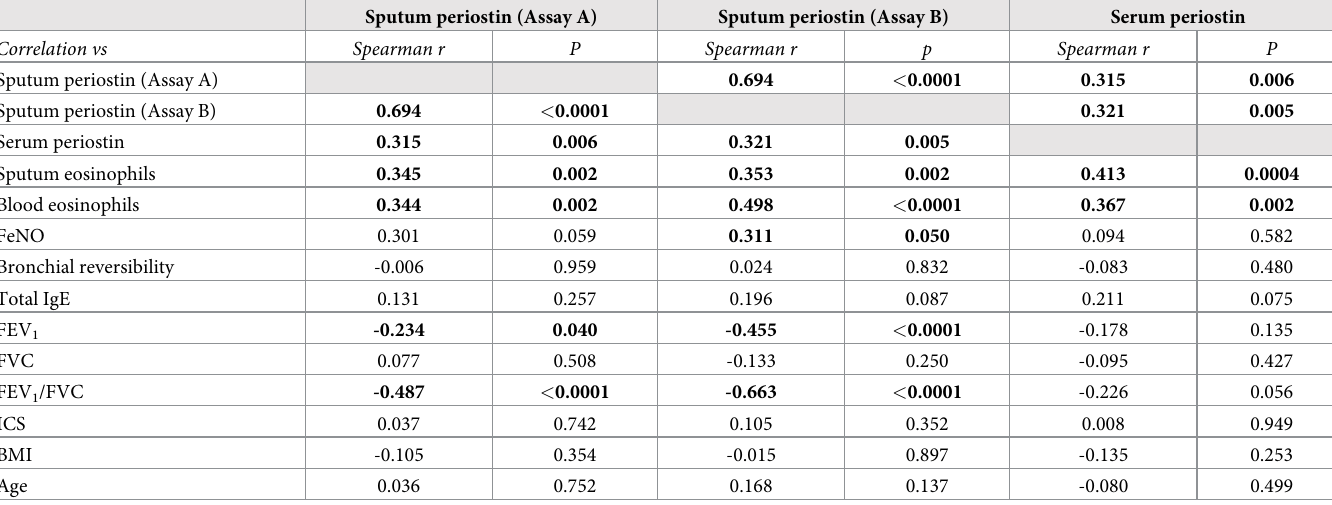
Table 2. Correlations between serum and sputum periostin and clinical characteristics in patients with asthma from BIOAIR study. Sputum periostin (Assay A) Sputum periostin (Assay